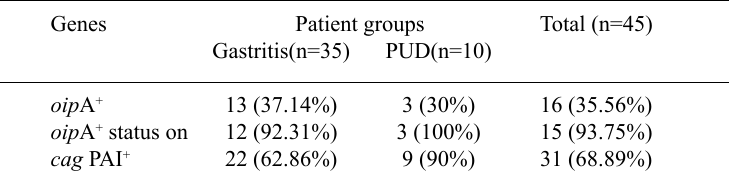
Table 3. Distribution of H. pylori cag PAI and oip A combined